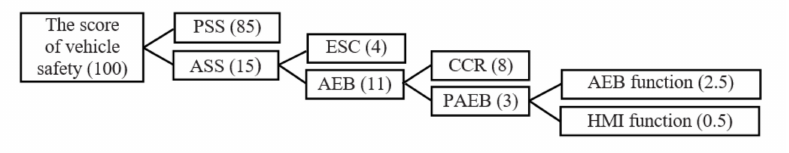
Figure 2. The relationship of scoring